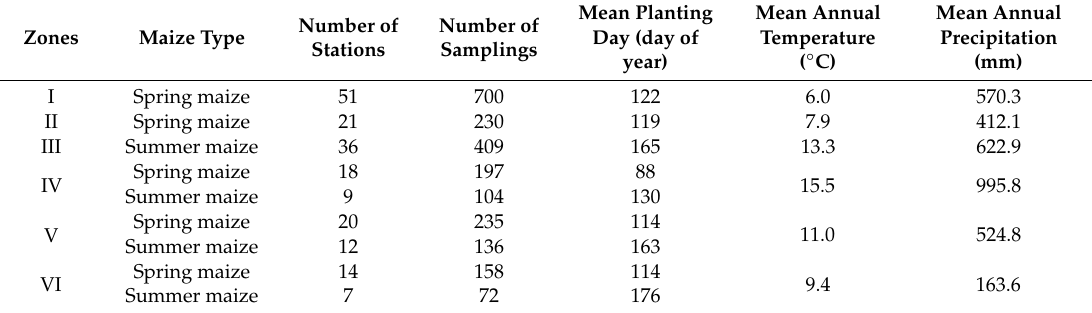
Table 1. General information about cultivation zones on mean climate, maize type, mean planting day during 1992–2010.